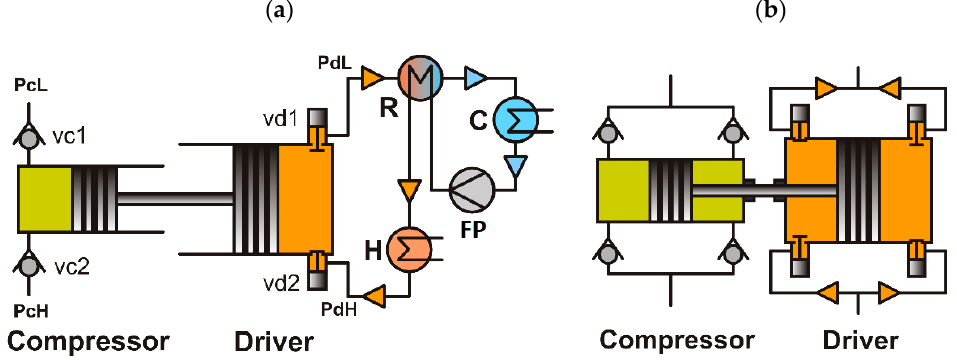
Figure 1. Basic schemes of vapor-driven compressors: ( a )—single-acting, ( b )—double-acting. The driver cylinder is combined with a vapor generation circuit (shown in the single- acting scheme) consisting of a heater H, recuperator R, cooler C and feed pump FP. The driver together with the vapor circuit forms an IE heat engine. Its operation is described in